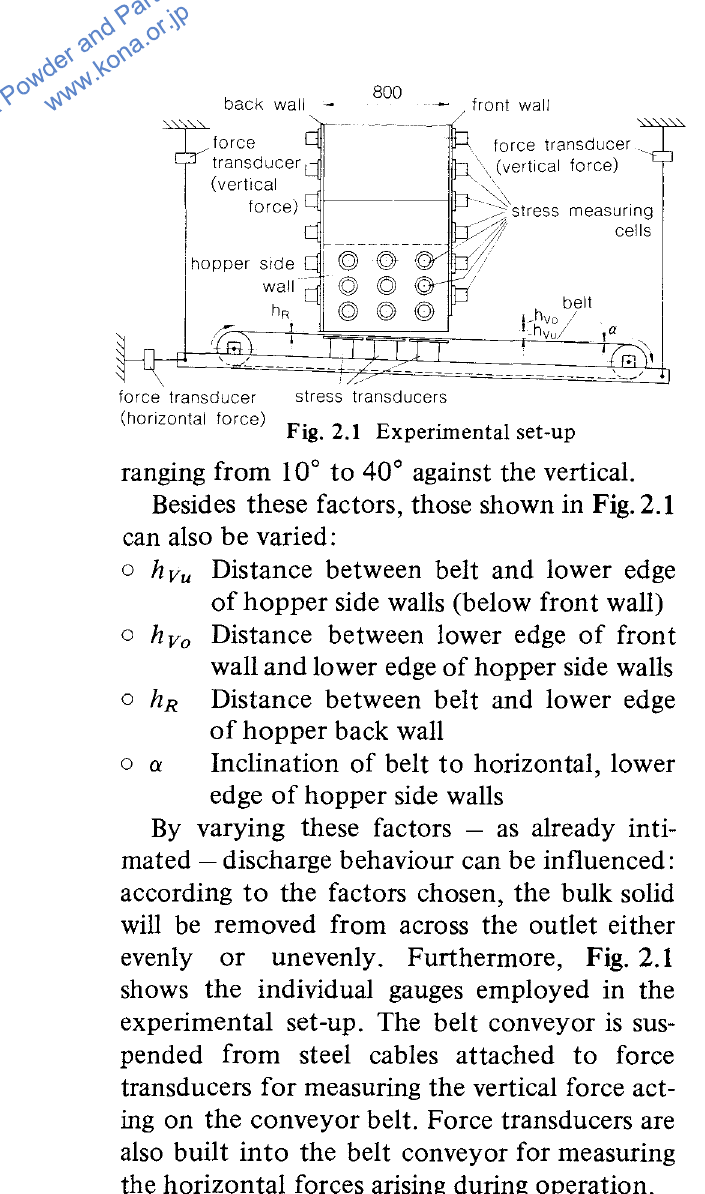
Table 2.1 Flow properties, measured in a J enike Shear Tester at major consolidation stresses o